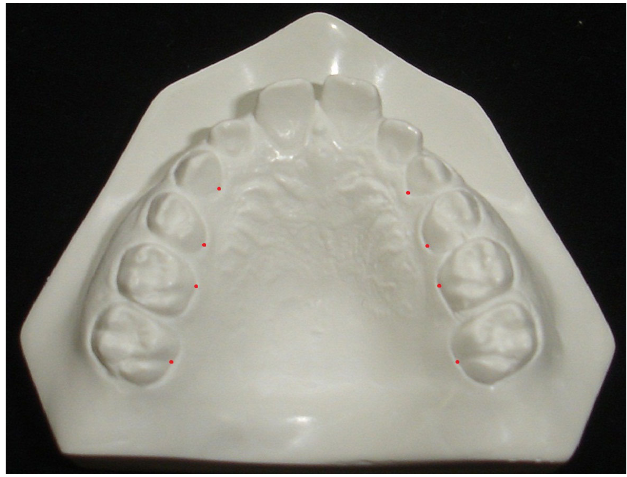
Fig. 1. Landmarks used to determine palate These measurements were made using a digital caliper (Western ® ) with 0.01mm of resolution and ± 0.02 mm of precision. For transversal measurements, the internal measuring faces of the instrument were used. For vertical measurements, a 0.05 mm stainless steel wire was cut with orthodontic pliers in the corresponding length to the transversal measurement and fixed with dental wax between the points in the level of each one of the considered tooth. After fixing the wire, the depth was measured with the depth measuring blade.